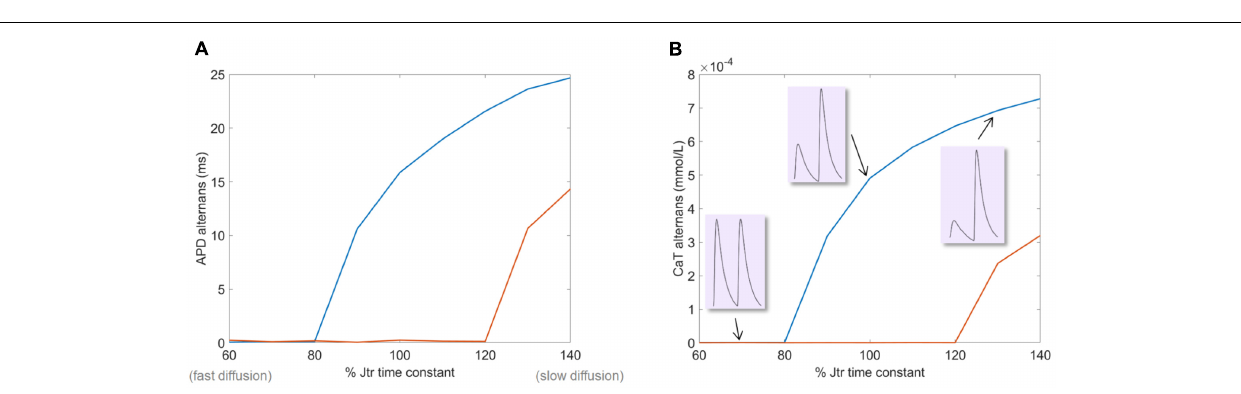
FIGURE 4 | The effect of varying NSR → JSR diffusion time constant on alternans amplitude in the HeRd model. (A) The amplitude of APD alternans at two pacing rates: 260 ms (where the baseline model with 100% value of time constant does manifest alternans) and 300 (where the baseline model does not manifest alternans). (B) The amplitude of calcium transient (CaT) alternans. In insets are shown examples of calcium transients at the end of the simulation of 260 ms bcl pacing, showing no alternans at 70% time constant, alternans at 100%, and exacerbated alternans at